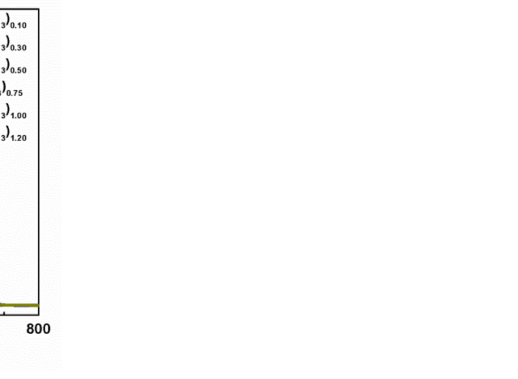
Figure 10. PL spectra of the (ZrO 2 ) 90 (Y 2 O 3 ) 10 − x (Ho 2 O 3 ) x crystals under the excitation at 446nm. The emission peaks at 540, 551, 670, and 757 nm correspond to the transitions from 5 S 5 F 5 F 5 I 5 I 3+ , respectively [47]. Although 2 , 4 , 5 , and 4 excited states to the 8 ground state Ho their relative intensities varied, the emission peaks positions were independent of Ho 2 O 3 concentrations. For Ho 2 O 3 concentrations were between 0.30 and 1.20 mol%, the strongest green emission peak was at 551 nm ( 5 S 2 → 5 I 8 ), whereas the strongest green emission was at 540 nm ( 5 F 4 → 5 I 8 ) for the (ZrO 2 ) 90 (Y 2 O 3 ) 9.90 (Ho 2 O 3 ) 0.10 sample. At low Ho 2 O 3 -doped concentrations (0.10 − 0.50 mol%), the emission intensity in- creased with Ho 2 O 3 contents and reached the maximum at 0.50 mol%, then decreased with higher Ho 2 O 3 contents (0.50 − 1.20 mol%) due to the concentration quenching effect.